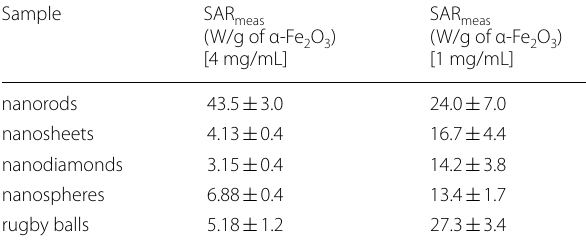
Table 3 Measured SAR values at two suspension concentrations